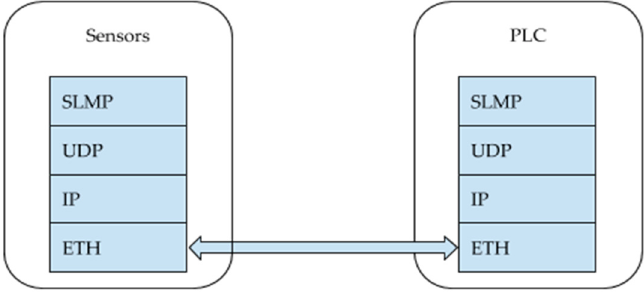
Figure 9. Organization of communication between the PLC and Odroid.